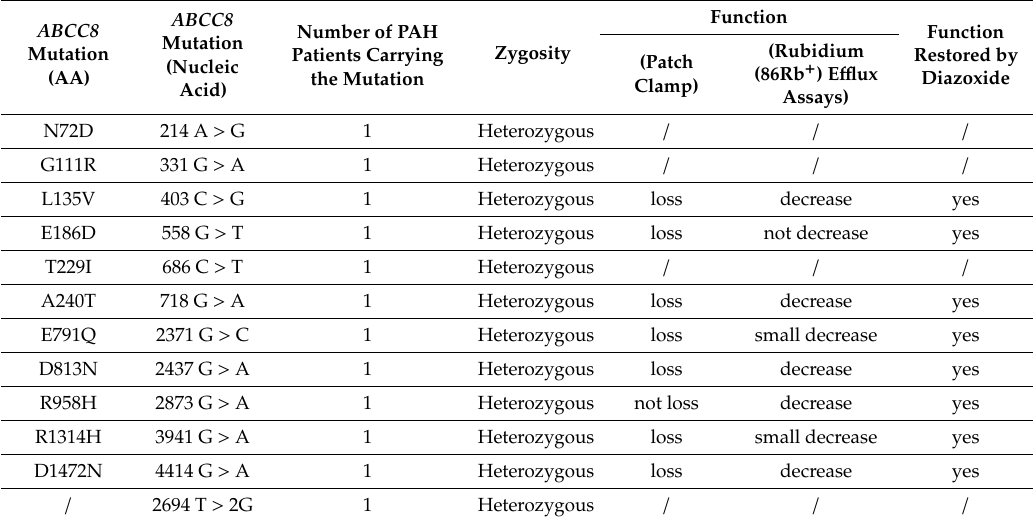
Table 2. ABCC8 mutations identified in PAH patients and their consequences for the Sur1 / Kir6.2 channel